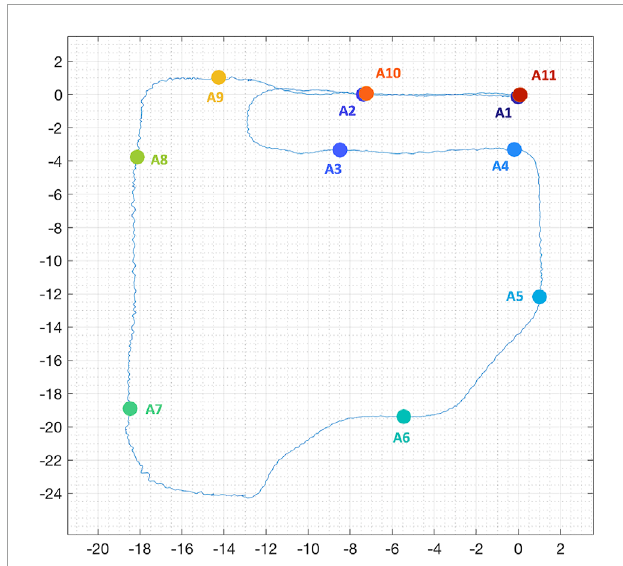
FIGURE 1 Position, in meters, of the selected eleven locations in the outdoor experiments, used for re-localization. The underlying blue line represents the first estimated trajectory with one of the systems.